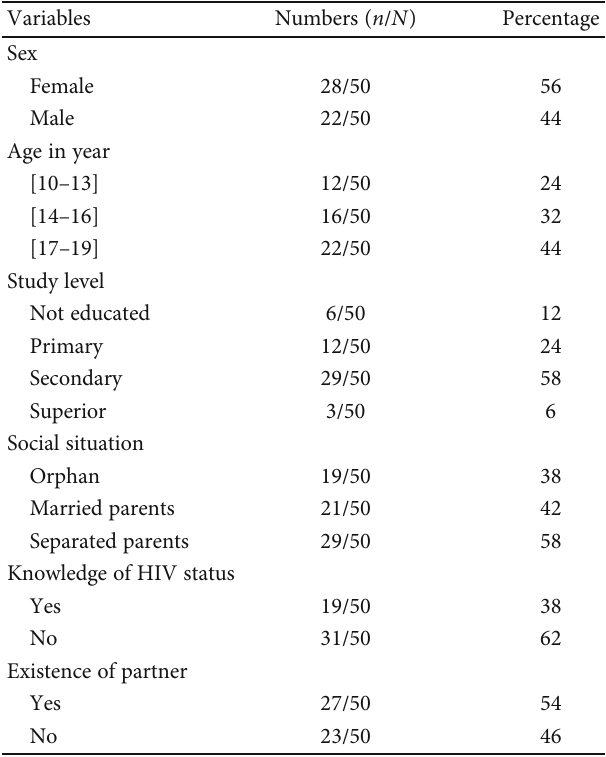
Table 1: Distribution by sociodemographic characteristics of HIV- positive adolescents ( N = 50 ).